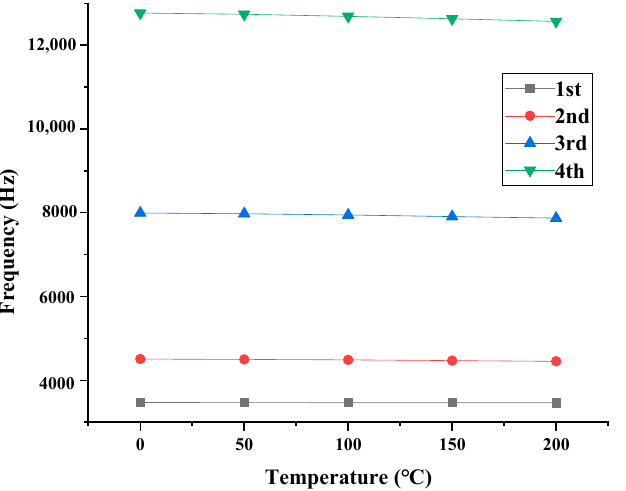
Figure 14. TWR characteristics of gears with different vibration mode at different temperatures.